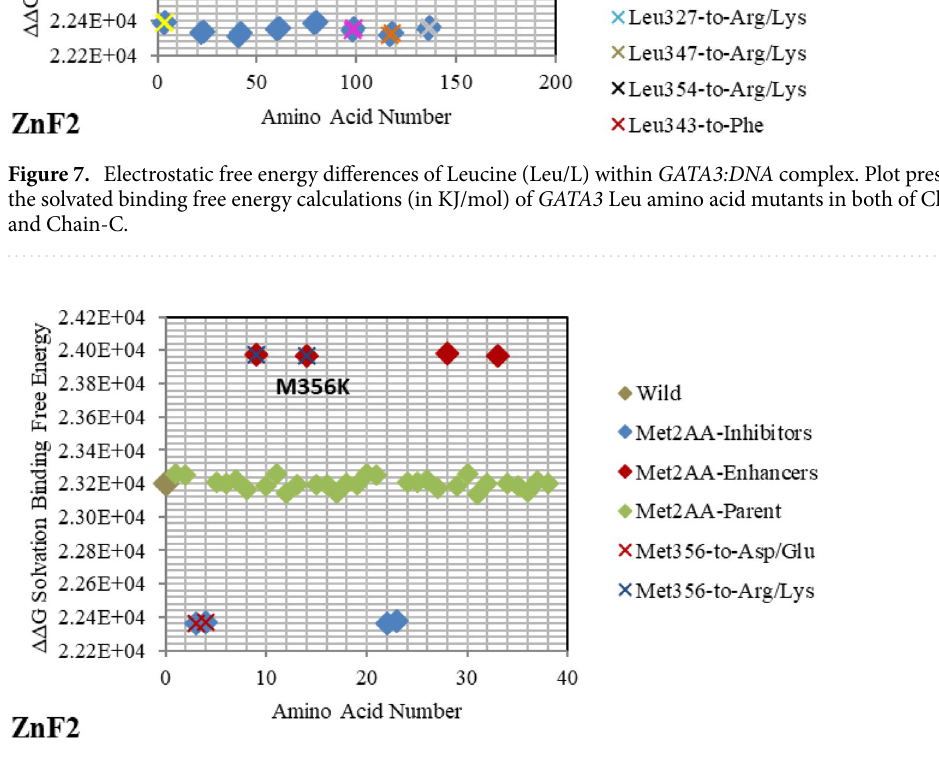
Figure 8. Electrostatic free energy differences of Methionine (Met/M) within GATA3:DNA complex. Plot presents the solvated binding free energy calculations (in KJ/mol) of GATA3 Met amino acid mutants in both of Chain-D and